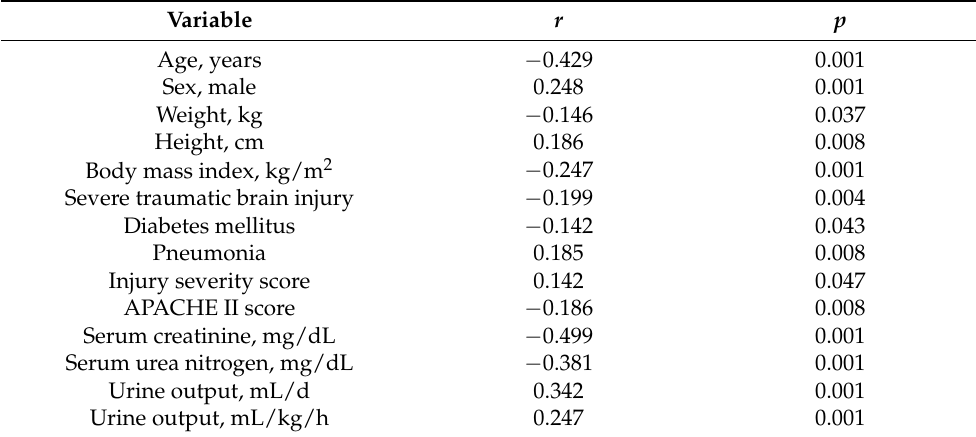
Table 5. Univariate correlation analysis between measured creatinine clearance and associated variables.